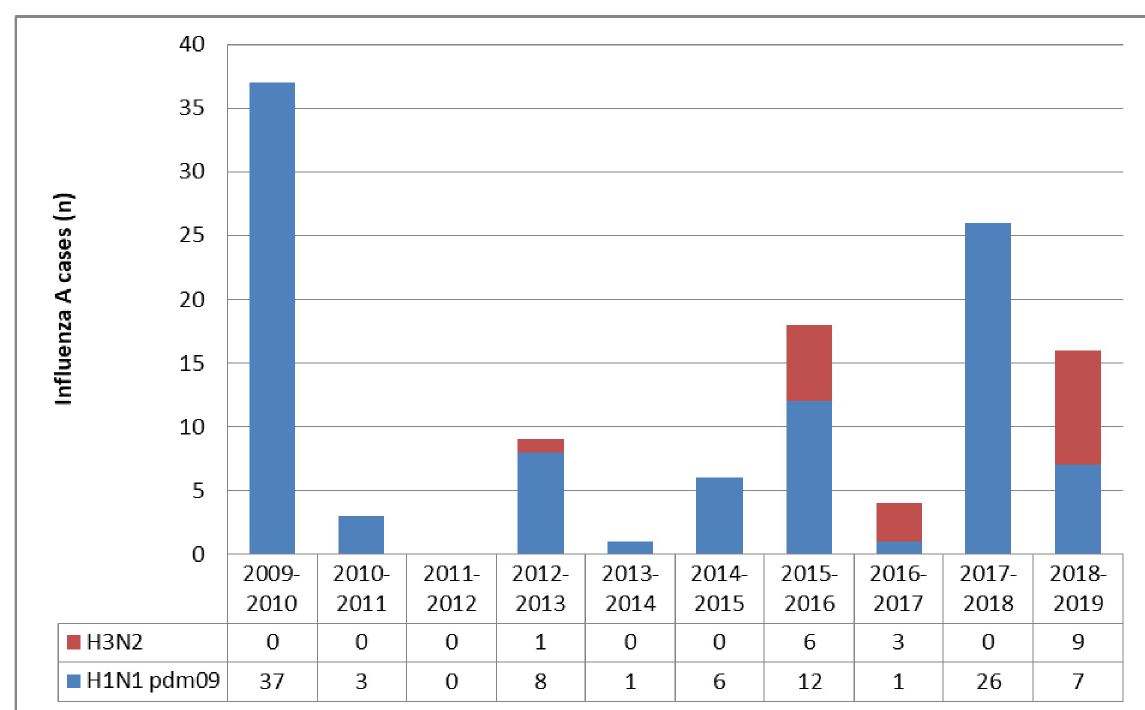
Fig 2. Influenza A strains distribution through 10 consecutive